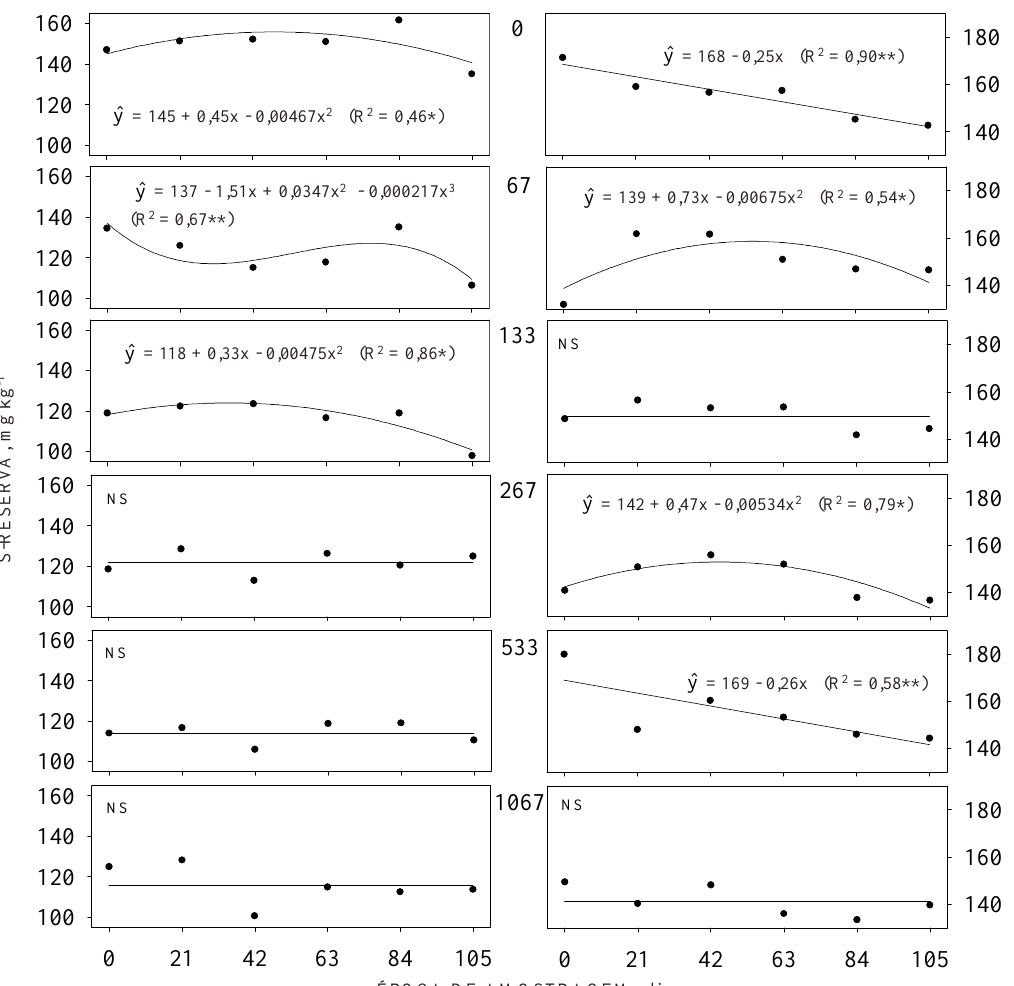
Figura 3. S-reserva, na média das profundidades de amostragem, de acordo com as épocas de amostragem e em cada dose de gesso, em Latossolo Vermelho distrófico típico cultivado com soja nos anos agrícolas de 1992/93 e 1993/94. *, ** e NS = Significativos a 5 e 1% pelo teste F, respectivamente, e